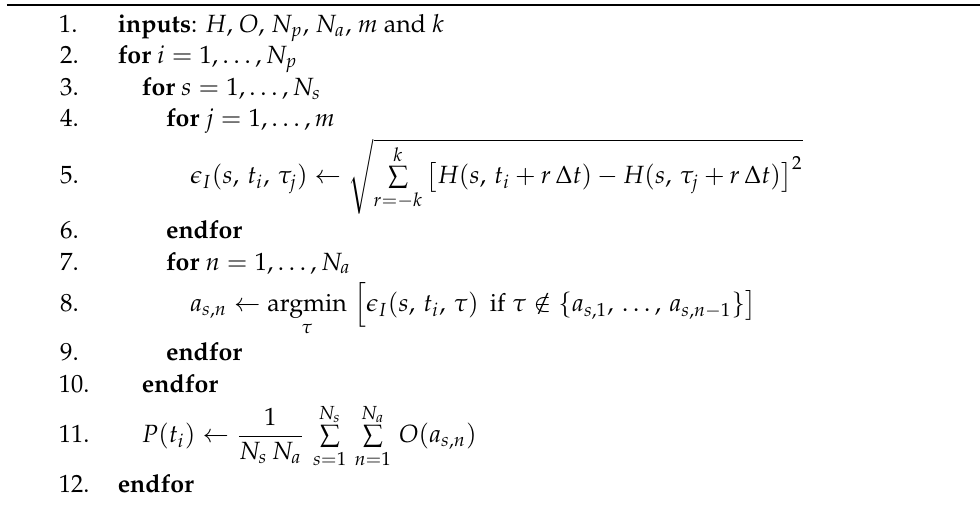
Algorithm 1: Classic AnEn for independent